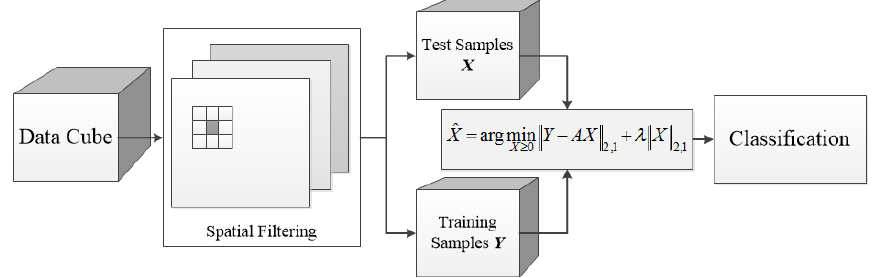
Figure 1. Flow chart of the proposed